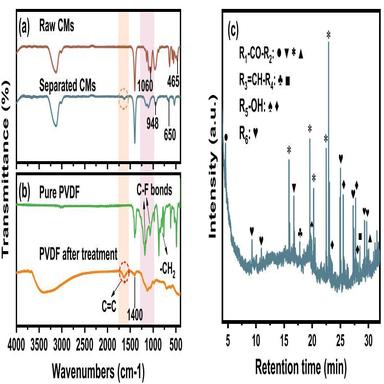
FT-IR spectra of materials before and after reaction, (a) LFP CMs, (b) PVDF; (c) GC-MS of extracts from degraded PVDF suspensions.